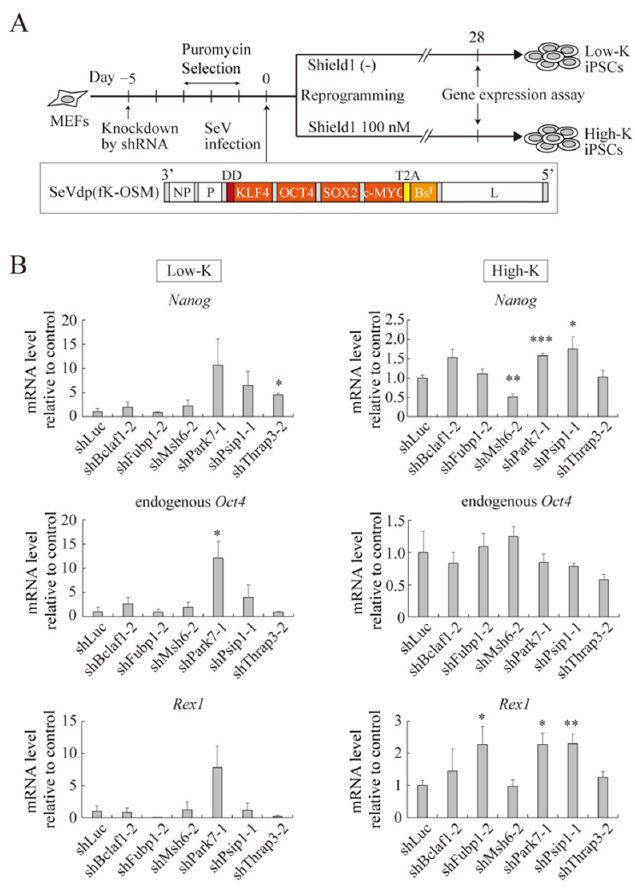
Figure 6. Effect of knockdown of identified proteins on somatic cell reprogramming. ( A ) Schematic representation of iPSC production with knockdown of identified proteins. MEFs were transduced with retroviral vector expressing each shRNA. After puromycin selection for 3 days, the selected